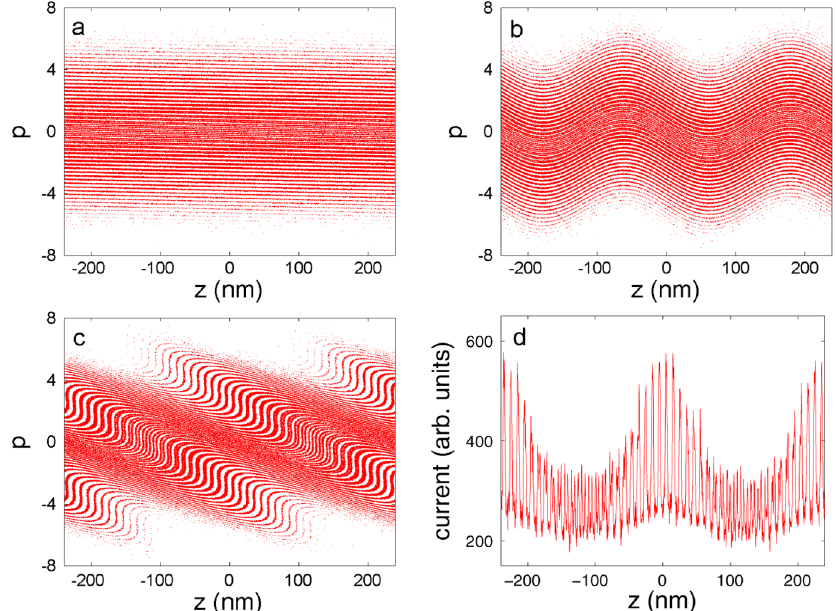
FIG. 6. (Color) Longitudinal phase space evolution in the EEHG scheme. (a) Phase space at the exit of dispersion section 1. (b) Phase space at the exit of modulator 2. (c) Phase space at the exit of dispersion section 2. (d) Current distribution at the exit of dispersion section